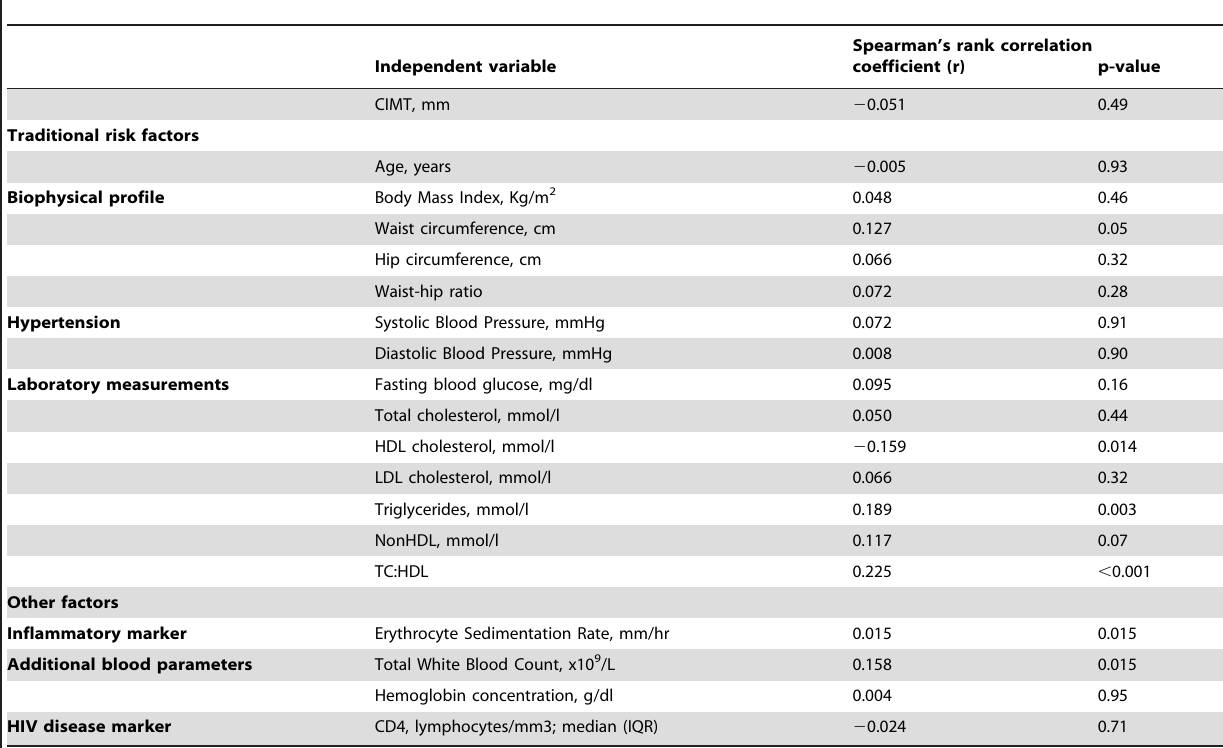
Table 4. Spearman correlation coefficients of hsCRP concentrations with CIMT and traditional cardiovascular risk factors among HIV infected